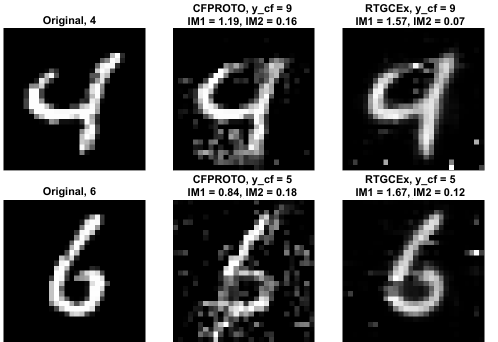
Figure 11. Examples of two counterfactual instances generated by CFPROTO and RTGCEx, where IM2 is lower when using RTGCEx, and IM1 is